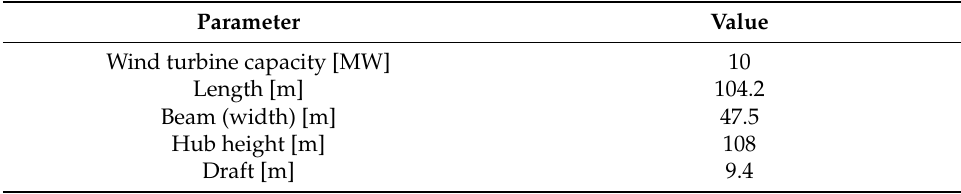
Table 1. Main properties of the SATH FOWT.